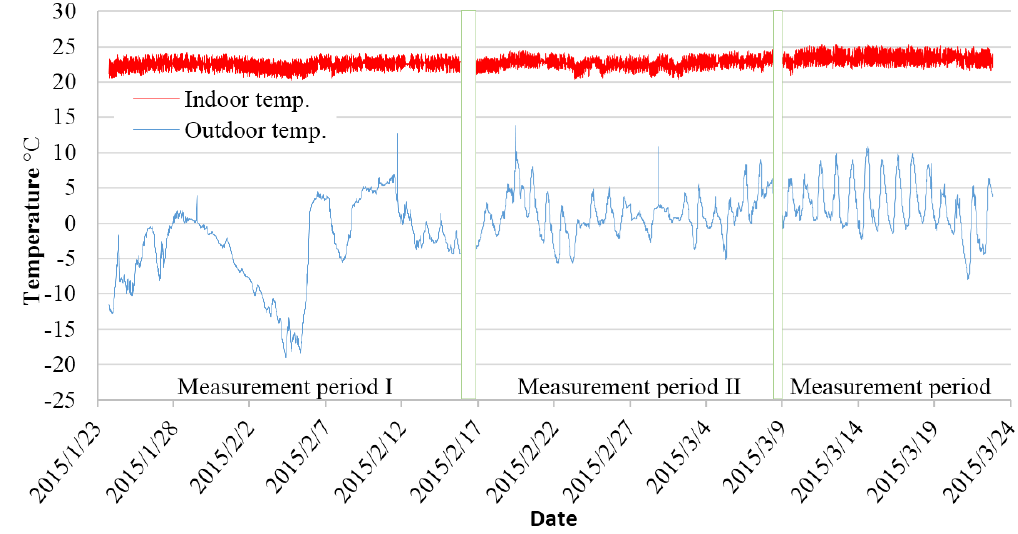
Figure A1. The indoor and outdoor ambient air temperatures with 15 min sampling interval between measurements. Infrastructures 2017 , 2 , x FOR PEER REVIEW